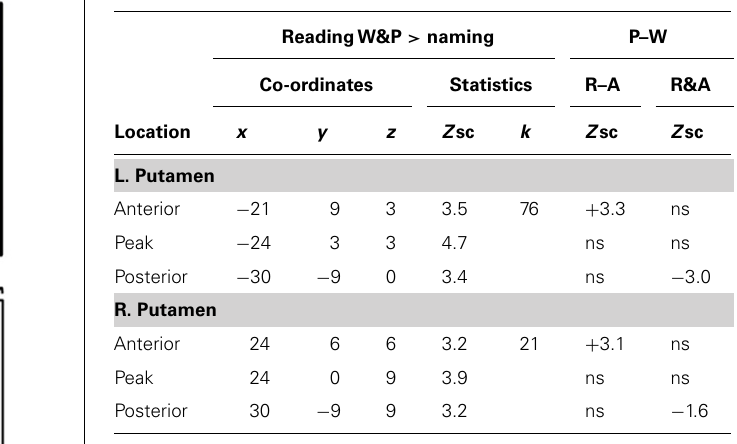
Table 1 | Location and effects in the left and right